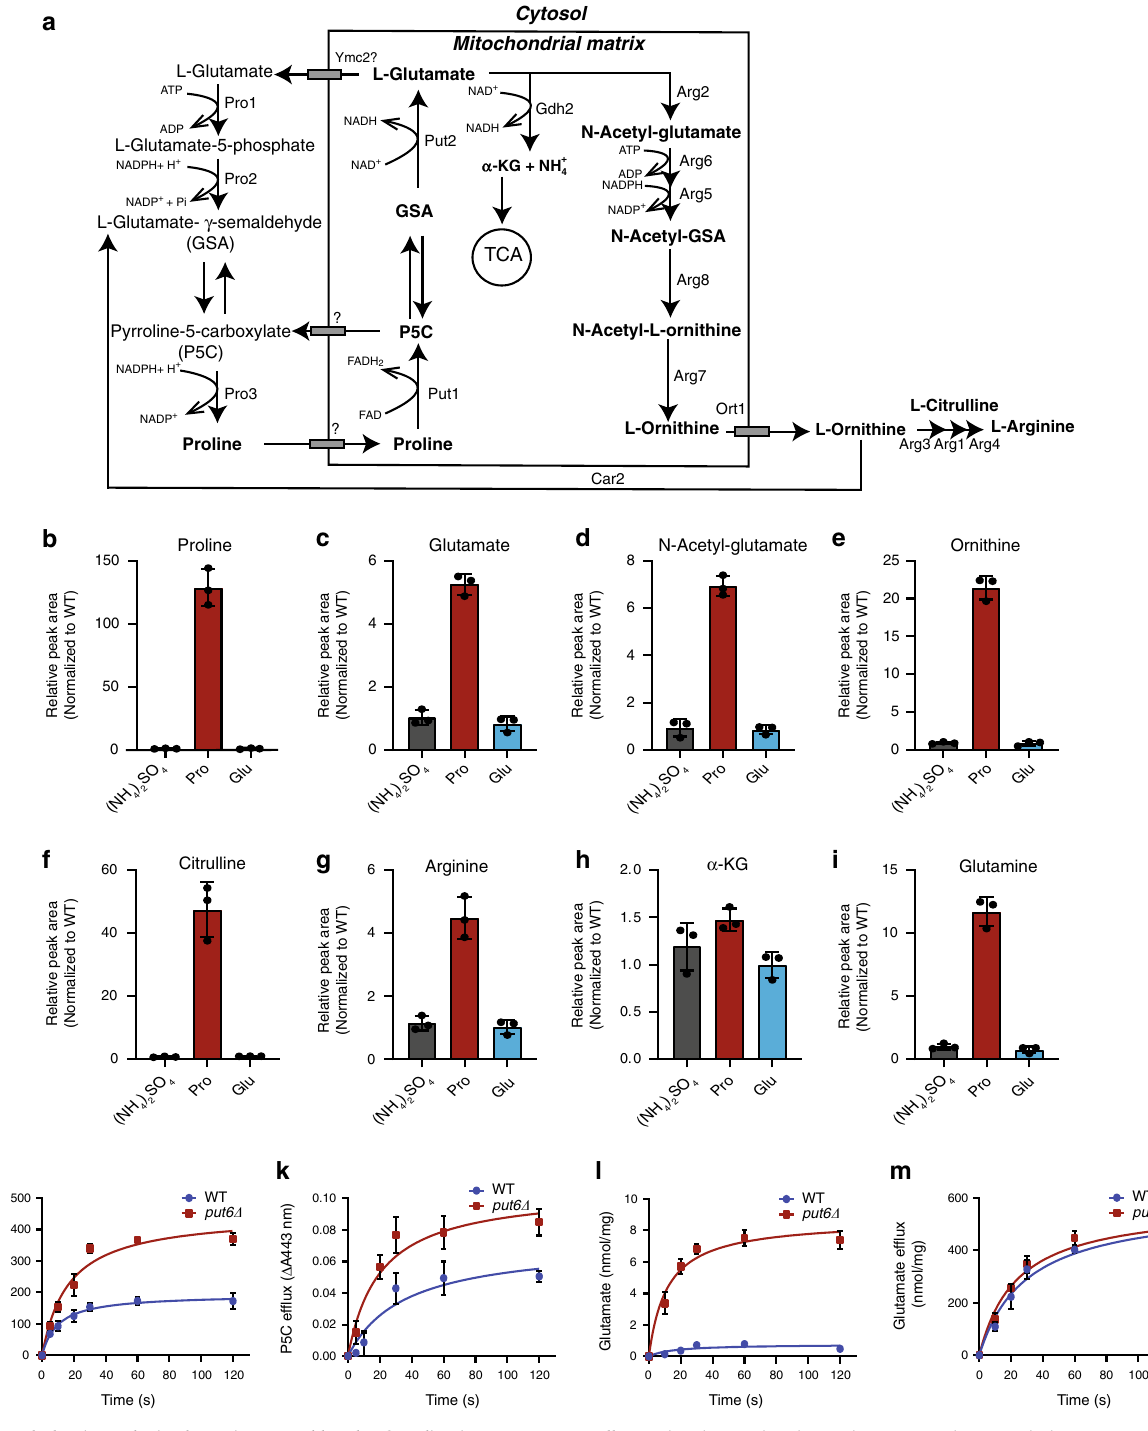
Fig. 5 Metabolomic analysis shows increased levels of proline in put6 Δ yeast cells. a A biochemical pathway depicting proline metabolism in S. cerevisiae . Proline catabolism occurs in mitochondria and is highlighted in bold letters. b – i LC-MS-based quanti fi cation of proline ( b ), glutamate ( c ), N-acetyl glutamate ( d ), ornithine ( e ), citrulline ( f ), arginine ( g ), α -ketoglutarate ( h ), and glutamine ( i ) in put6 Δ yeast cells cultured in indicated nitrogen source (Pro — proline, Glu — glutamate). Data were normalized to WT and plotted as mean ± SD ( n = 3 biologically independent experiments). j Time course of [ 14 C] proline uptake in isolated mitochondria from ACY WT and put6 Δ yeast cells grown in proline as the sole nitrogen source. All the data points were normalized to time zero and plotted as mean ± SD ( n = 3 biologically independent experiments). k – m Time course of P5C ef fl ux ( k ), glutamate accumulation ( l ), and glutamate ef fl ux ( m ) in WT and put6 Δ mitochondria following 1 mM proline addition. All the data points were normalized to time zero and plotted as mean ± SD ( n = 3 biologically independent experiments). WT and mutants used in this panel are from prototrophic ACY genetic background (see Supplementary Table 1). Source data are provided as a Source data fi